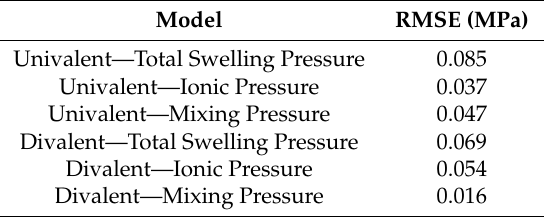
Table 3. Root Mean Square Error (RMSE) between theoretical predictions and simulation results.